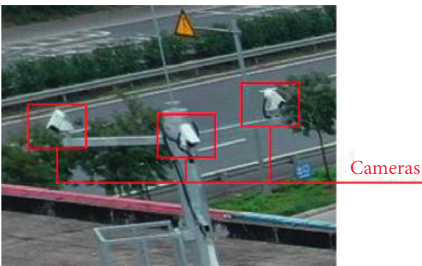
Figure 2: Installation of the surveillance cameras in the CCTV tower.